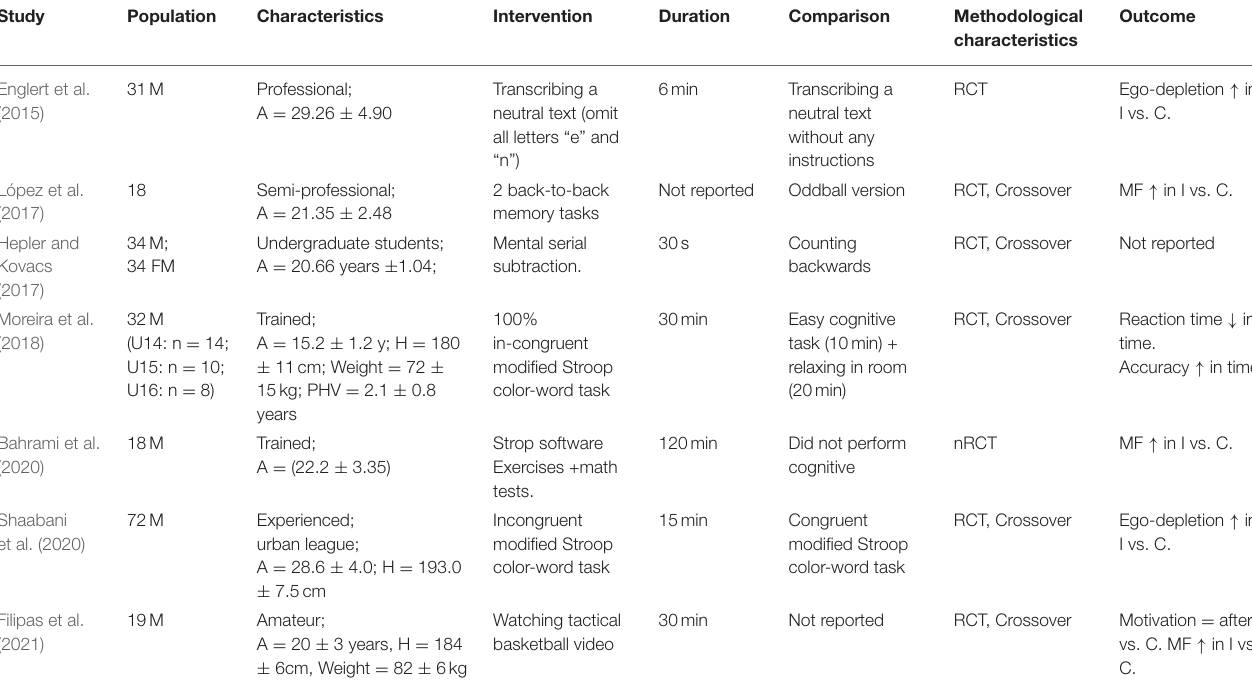
TABLE 3 | Overview of the mental fatigue—inducing